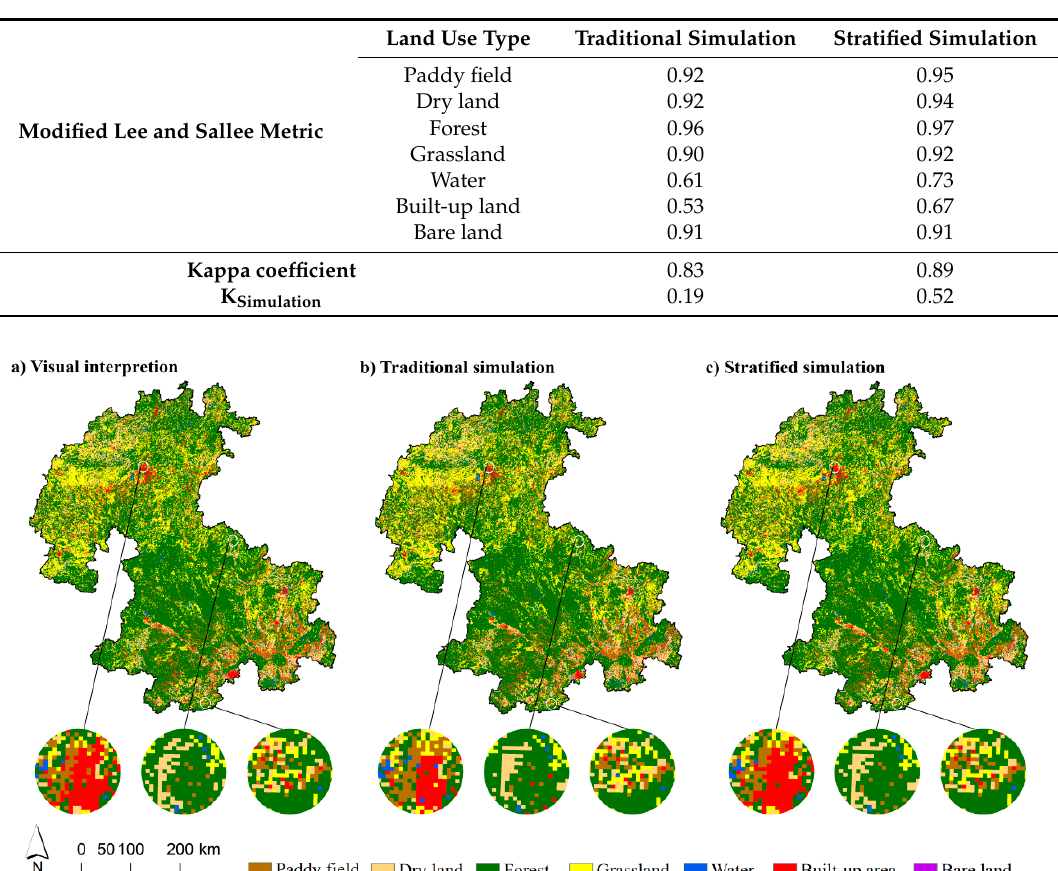
Table 6. Accuracy assessment of land use change simulation.